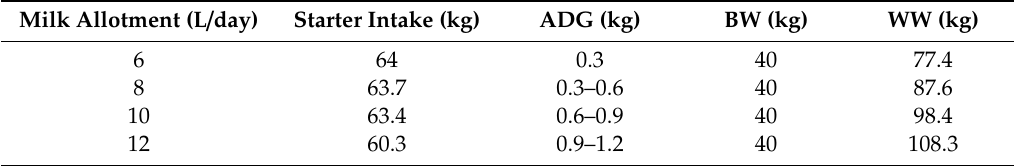
Table 2. Birth weight and weaning weight were a result of milk allotted and calf starter intake per calf following experimental data from Rosenberger et al. 2017. Average daily gain (ADG) followed the equation presented in NRC